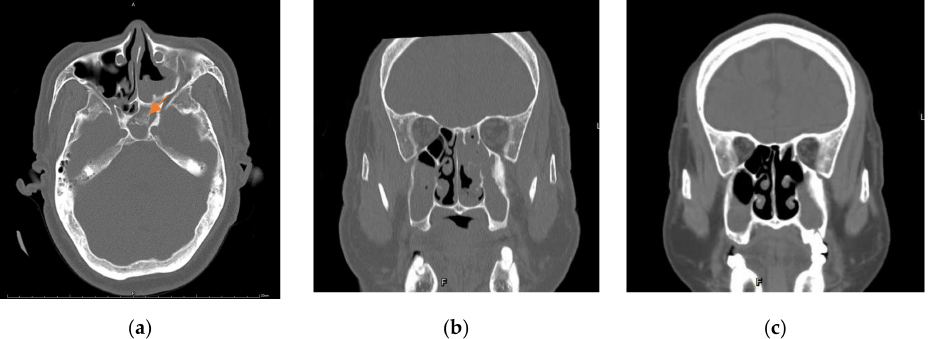
Figure 1. Computed tomography. ( a ) Significant calcification in the sphenoid sinus (arrow). ( b ) Dif- fuse mucoperiosteal thickening in the bilateral maxillary, ethmoid, and sphenoid sinuses before rituximab treatment. ( c ) Reduced inflammation in the mucosa in the bilateral maxillary, ethmoid, and sphenoid sinuses after rituximab